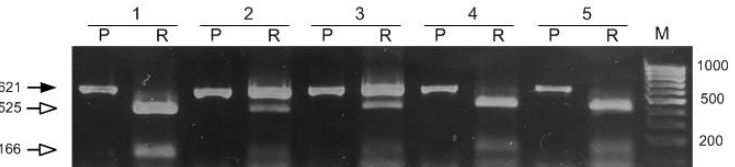
Figure 1. The electrophoretic pattern of separation of PCR fragments of the α CA4 gene of T1 plants before and after treatment with an Asp S9I restriction enzyme in 1.5% agarose gel. Designations: 1 – 5 are the numbers of the corresponding plants; M‒DNA marker Step 100 (Biolabmix, Russia), lengths of fragments in bp are indicated on the right; (P)—PCR fragment of the α CA4 gene of the respective plants, and (R)—the result of Asp S9I restriction of the corresponding PCR fragment of the α CA4 gene. The black arrow indicates the initial PCR fragment; the white arrows indicate the fragments obtained after Asp S9I digestion; the size of the fragments is indicated in bp.